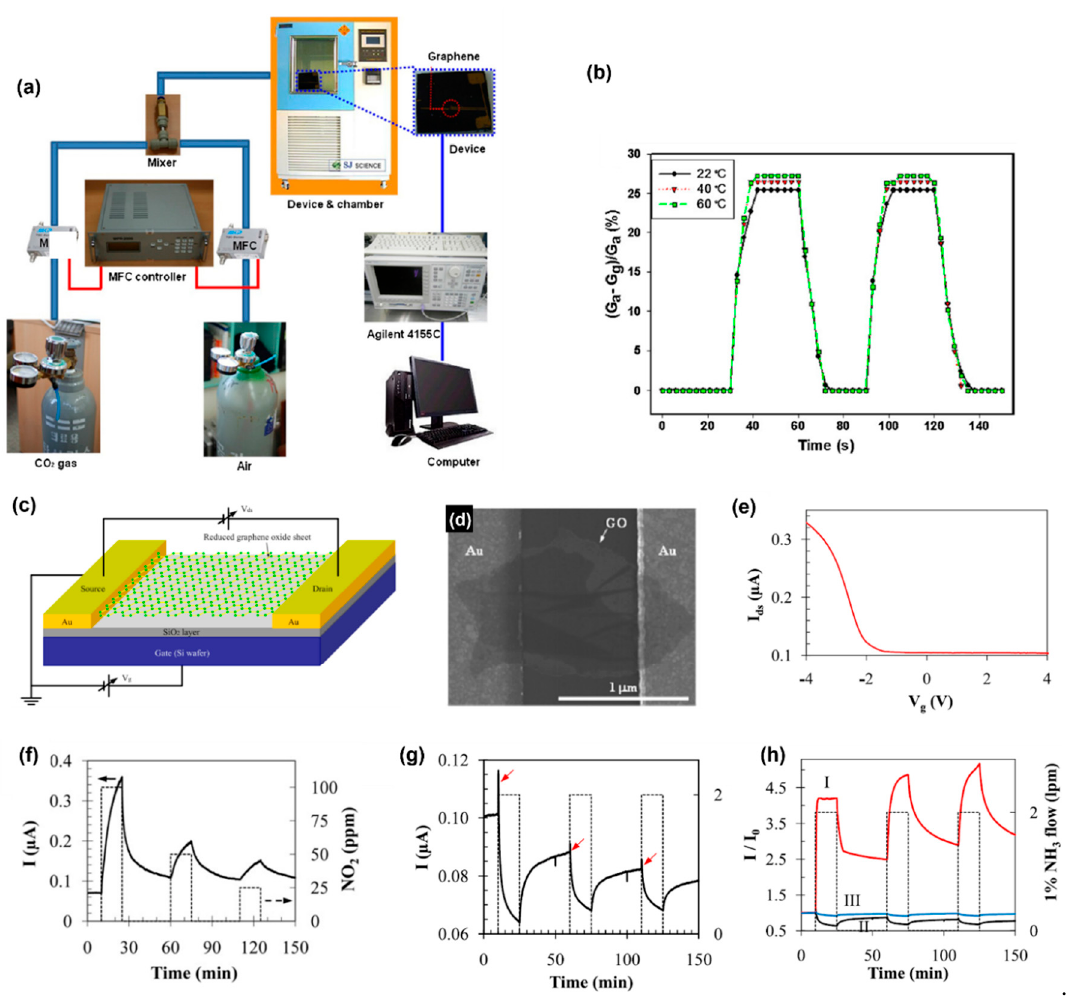
Figure 5. ( a ) Experimental setup for CO 2 gas sensor. ( b ) Real-time response of the sensor in conductance at 100 ppm CO 2 gas at different temperatures. ( c ) rGO gas sensor. ( d ) Scanning Electron Microscope (SEM) image showing a deposited GO sheet that bridges the gap between two Au electrodes. ( f ) The I ds -V g curve of the multi-step annealing fabricated sensor. ( e ) Detection of NO 2 at different concentrations by a multi-step heating fabricated rGO sensor at room temperature. ( f ) Detection of 1% NH 3 by a one-step annealing fabricated rGO sensor. ( g ) I: Response of rGO sensor for 1% NH 3 obtained from ( h ), II: Response of the reused rGO sensor after 2 months for 1% NH 3 III: Response of the reused rGO sensor treated with another heating. Reprinted with permission from References [91,92].